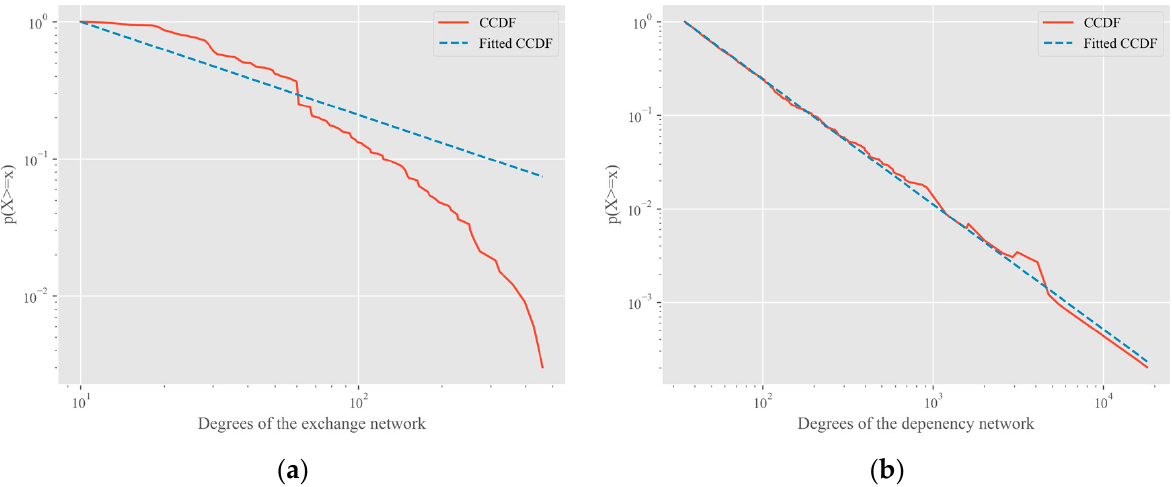
Figure 3. Analysis of degree distributions on ( a ) the exchange network and ( b ) the dependency network. The exchange network shows a poor power-law fit; the dependency network also shows a poor fit.